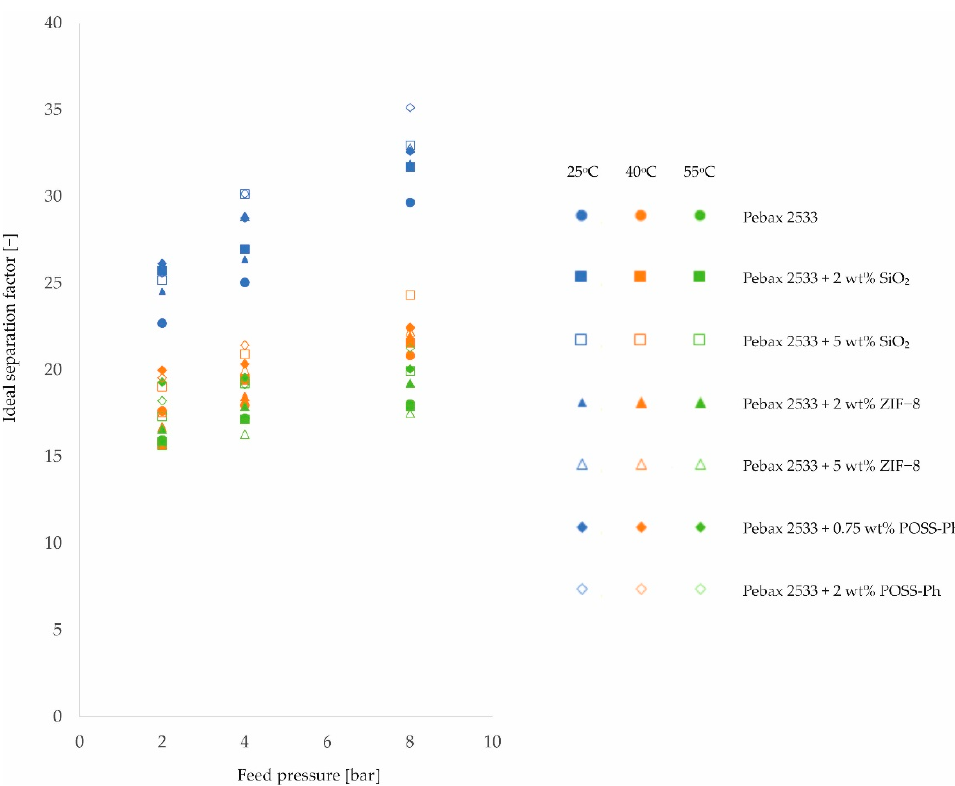
Figure 10. Change in ideal separation factor values for a N 2 /CO 2 mixture of homogeneous membrane and heterogeneous membranes containing SiO 2 , ZIF − 8, and POSS ‐ Ph for different feed pressure and temperature values.